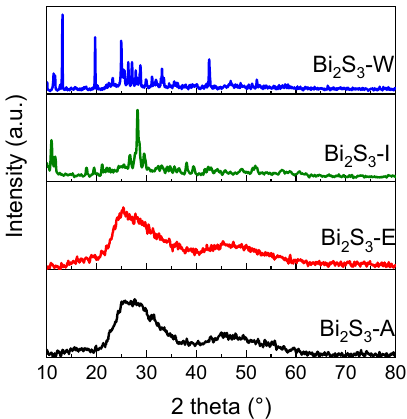
Figure 2. XRD patterns of the synthesized